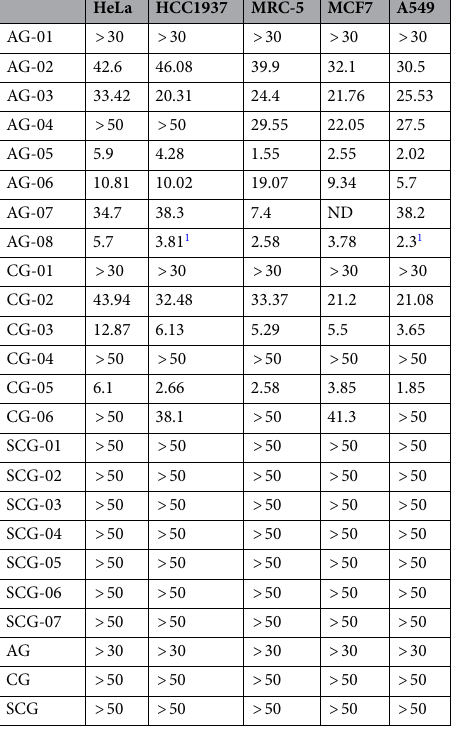
Table 3. IC 50 values (µM) of the analogs and their parent molecules. ND not